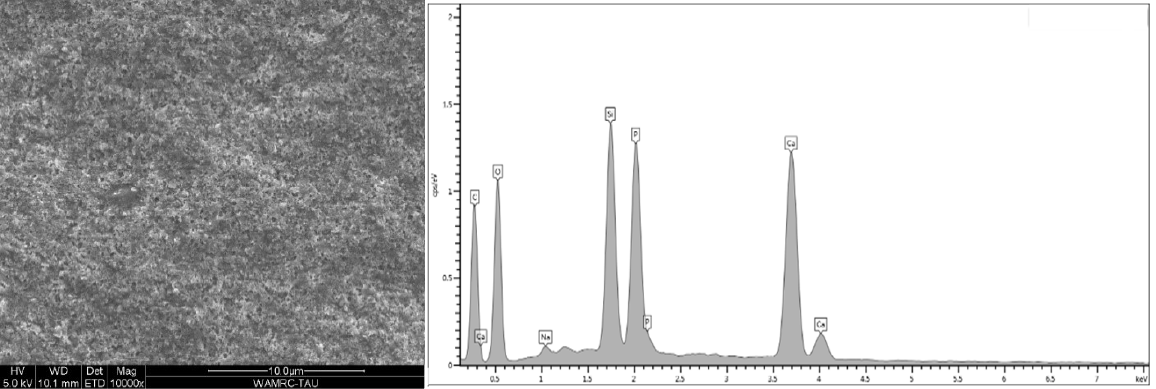
Figure 11. Microscopic image of air-abraded and CLSE primer- and adhesive-treated dentin. Adhesive covers the dentin surface; very few open dentinal tubules are still seen. EDS analysis revealed the following elements (wt %): C 40.98%, O 35.04%, Ca 10.51%, P 6.85%, Si 6.08%, and Al 0.1%.